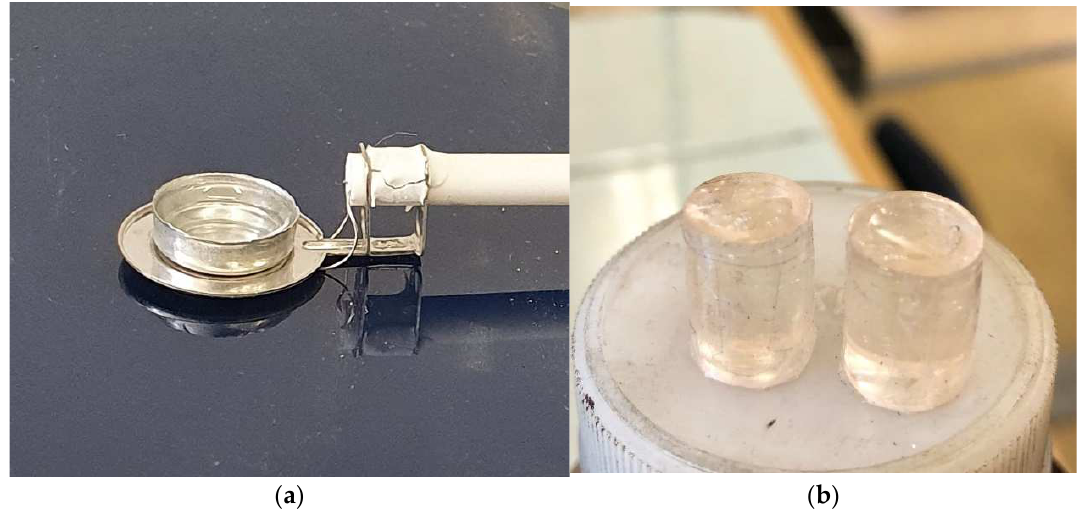
Figure 8. ( a ) Aluminum cup with azide mass for volatility measurement; ( b ) Charges of azides thickened with 4% nitrocellulose in Plexiglas tubes prepared to determine the burning rate.